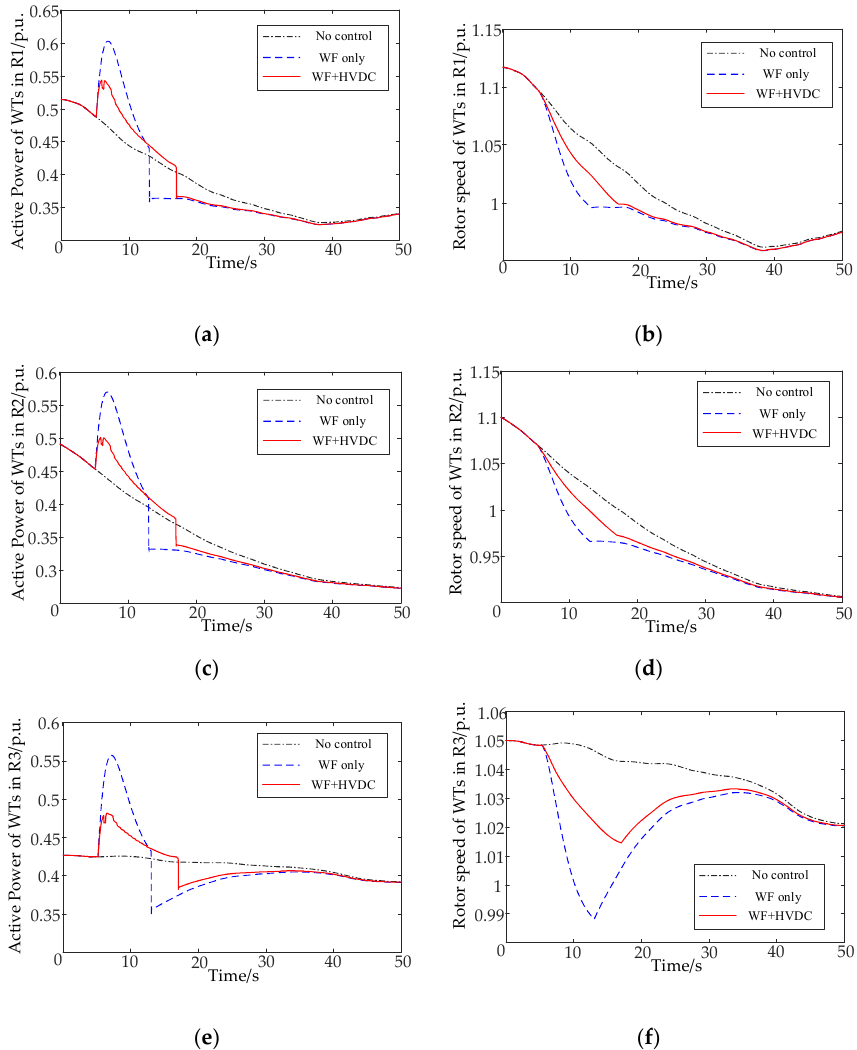
Figure 19. Active power and rotor speed of WTs in each subarea. ( a ) Active power of WTs in R1, ( b ) rotor speed of WTs in R1, ( c ) active power of WTs in R2, ( d ) rotor speed of WTs in R2, ( e ) active power of WTs in R3, and ( f ) rotor speed of WTs in R3. Table 7. Simulation results under middle wind power permeability and variable wind speed con- dition.